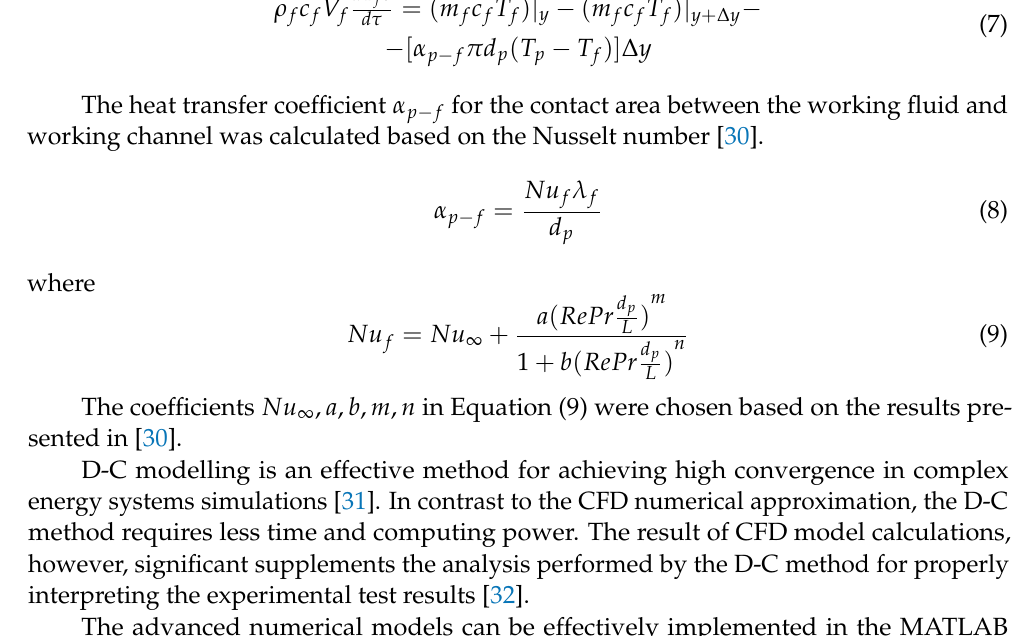
Figure 7. Energy balance of the working fluid.